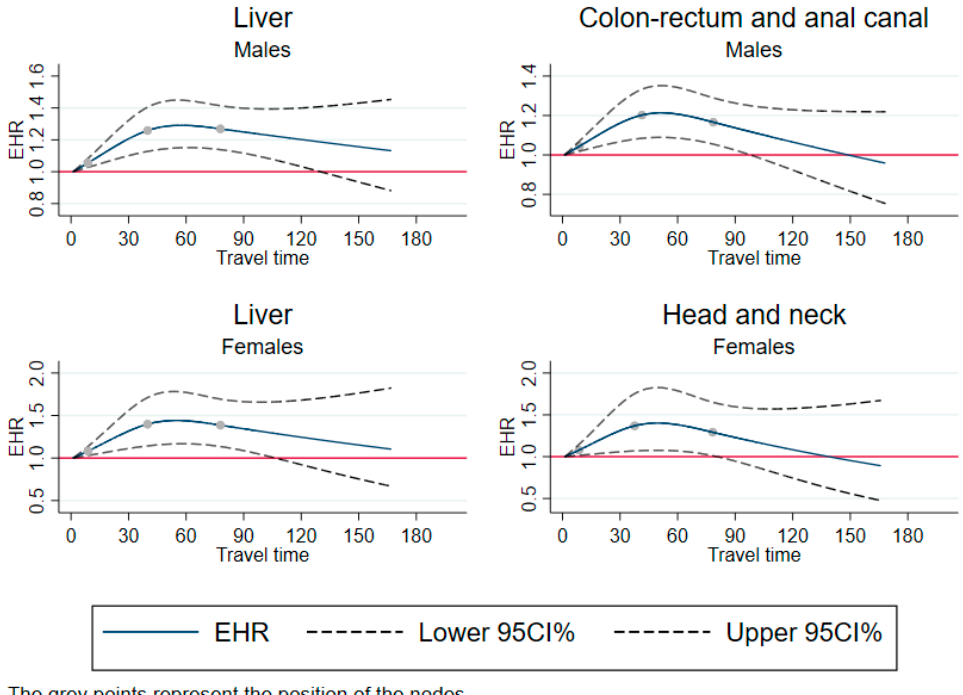
Figure 2. Excess mortality rates as a function of travel time, using restricted cubic splines—cases with reverse U-shape pattern. EHR: excess hazard ratio; CI: confidence Interval; travel time: travel time in minutes Adjusted for year of diagnosis, age, and European Deprivation Index.